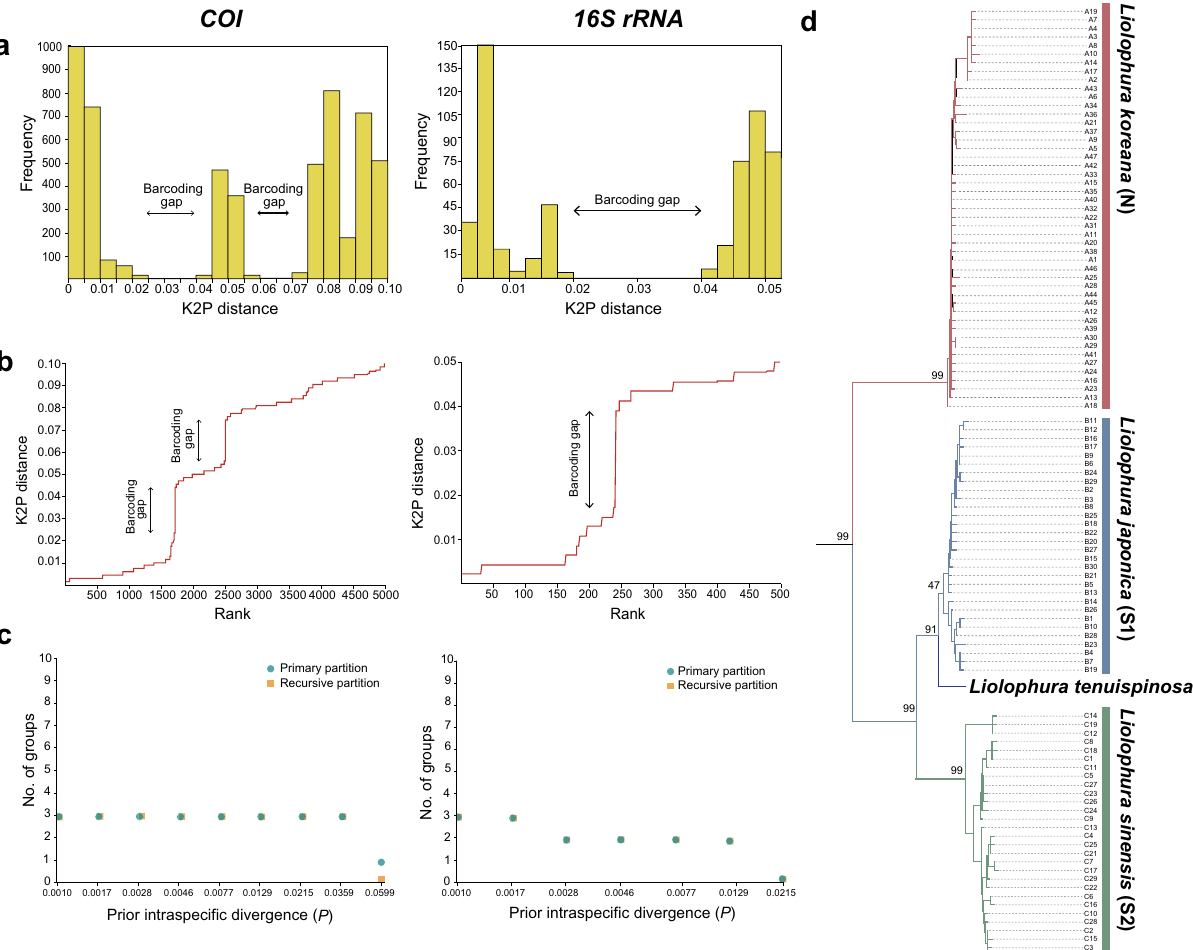
Figure 4. Distribution of pairwise genetic divergences, ranked pairwise difference, and automatic partition based on COI and 16S rRNA haplotypes of Liolophura japonica and a COI-based NJ tree showing the phylogenetic relationship with a congeneric species L. tenuispinosa . (a) Distribution patterns of pairwise genetic divergences observed in COI and 16S rRNA for L . japonica . The horizontal axis represents intervals of pairwise Kimura-2-parameter (K2P) genetic distance in percentage, and the vertical axis represents the number of individuals associated with each distance interval. (b) The results of ranked pairwise differences based on COI and 16S rRNA , ranked by ordered value, which is similar to the distribution of pairwise genetic divergence in ( a ). The horizontal axis indicates a ranked ordered value based on K2P genetic distance, and the vertical axis represents the K2P genetic distance in percentage. (c) The results of automatic partition analyses based on COI and 16S rRNA . The horizontal axis represents the prior maximum intraspecific divergence ( P ), and the vertical axis represents the number of groups inside the partitions (primary and recursive). (d) A COI -based NJ tree with L. tenuispinosa . Refer to Fig. S3 and Data